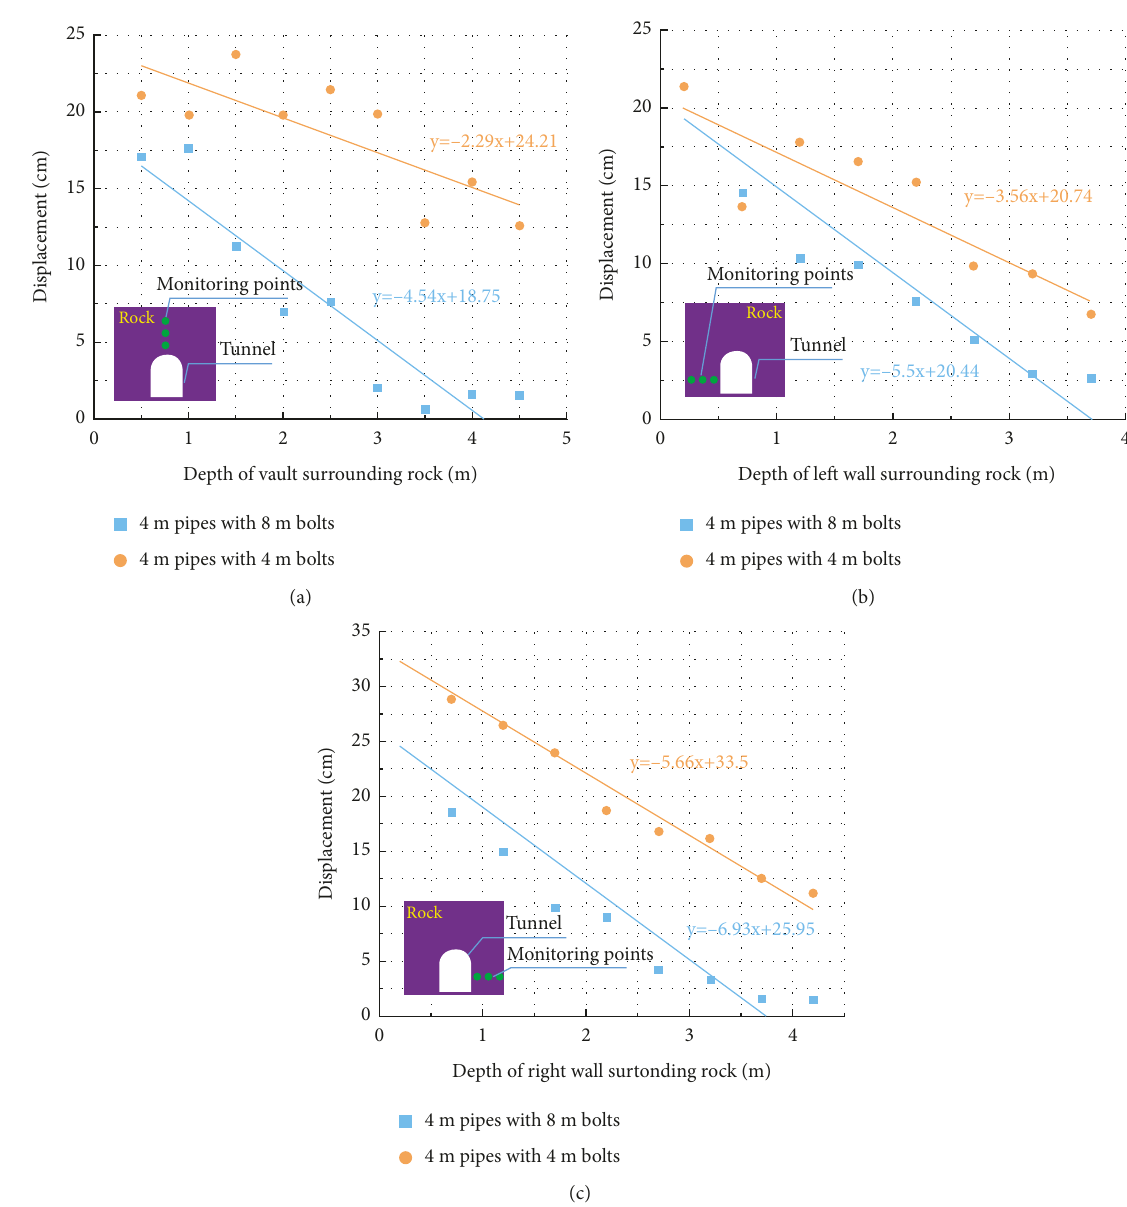
Figure 17: Final displacement of the surrounding rock (enlarged): (a) surrounding rock of vault; (b) surrounding rock of left side wall; (c) surrounding rock of right side wall.